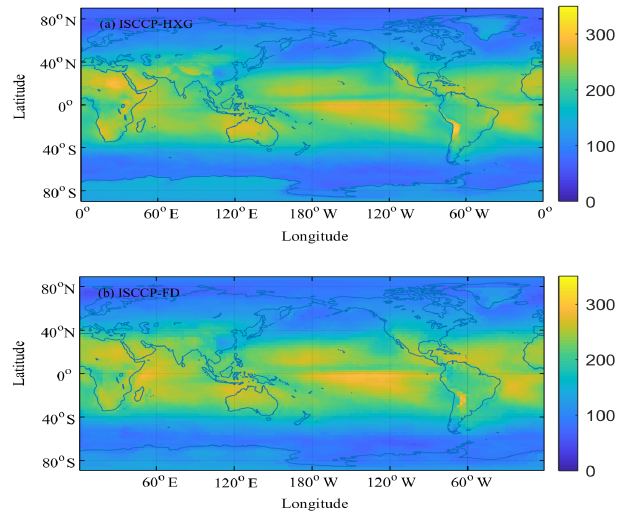
Figure 11. Spatial distribution of global annual mean SSR (Wm − 2 ) of (a) ISCCP-HXG and (b) ISCCP-FD in